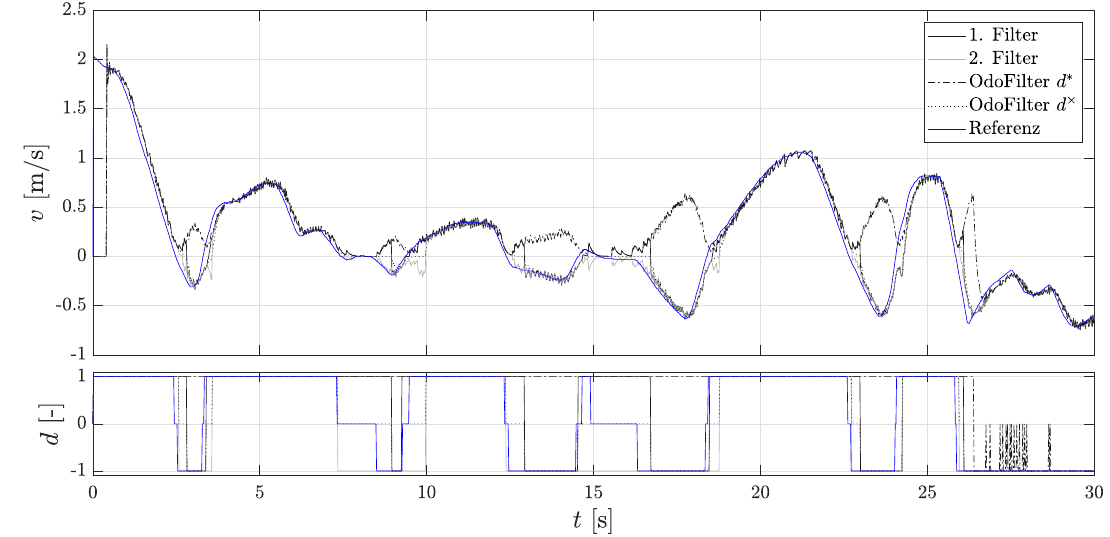
Figure 9. Velocities of the Dual-Localization filter on the slope hill. ( Top ): The velocity of the 1st and the 2nd localization filter, the velocity of the localization filter using the fused estimated rolling direction of the new methods, the velocity of the localization filter using the rolling direction of the DWPC signal, and the reference velocity; ( Bottom ): Rolling